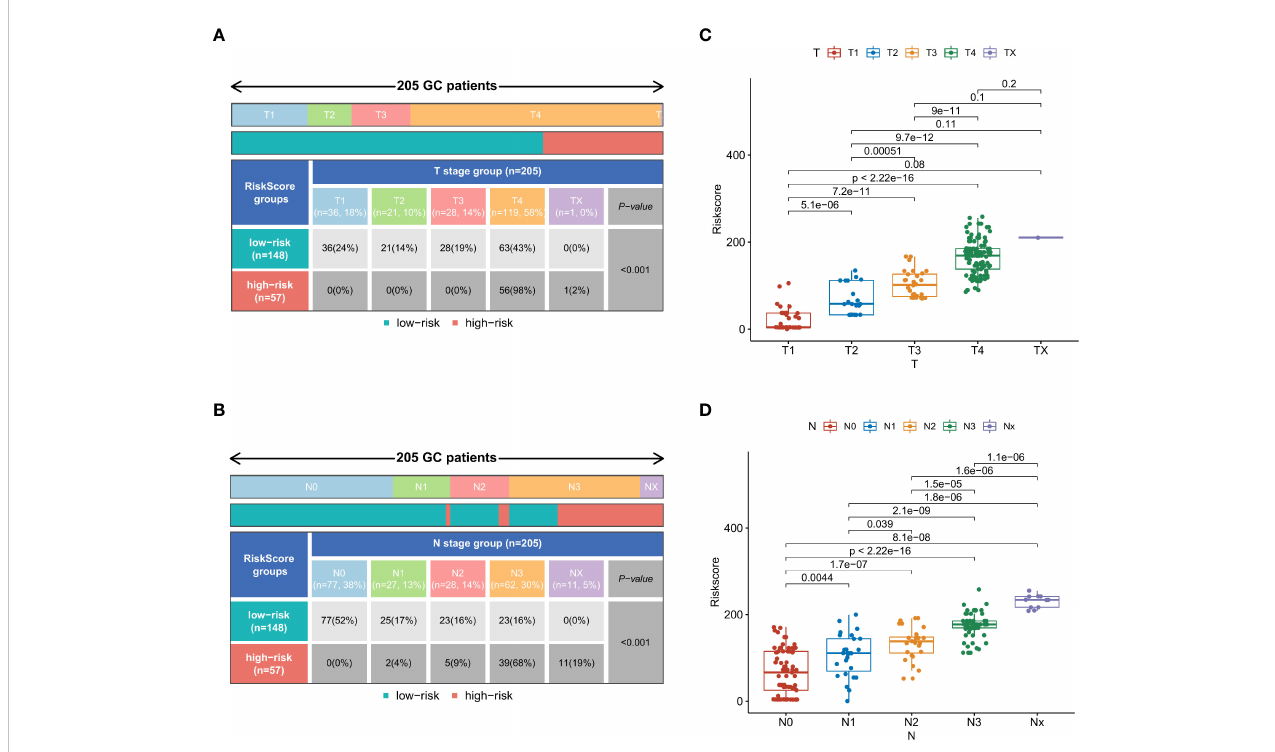
FIGURE 7 In the external validation set, the chi-square test results of risk strati fi cation patients with different T stages (A) and N stages (B) . Comparison of risk scores between different subgroups in T-stage (C) and N-stage (D)